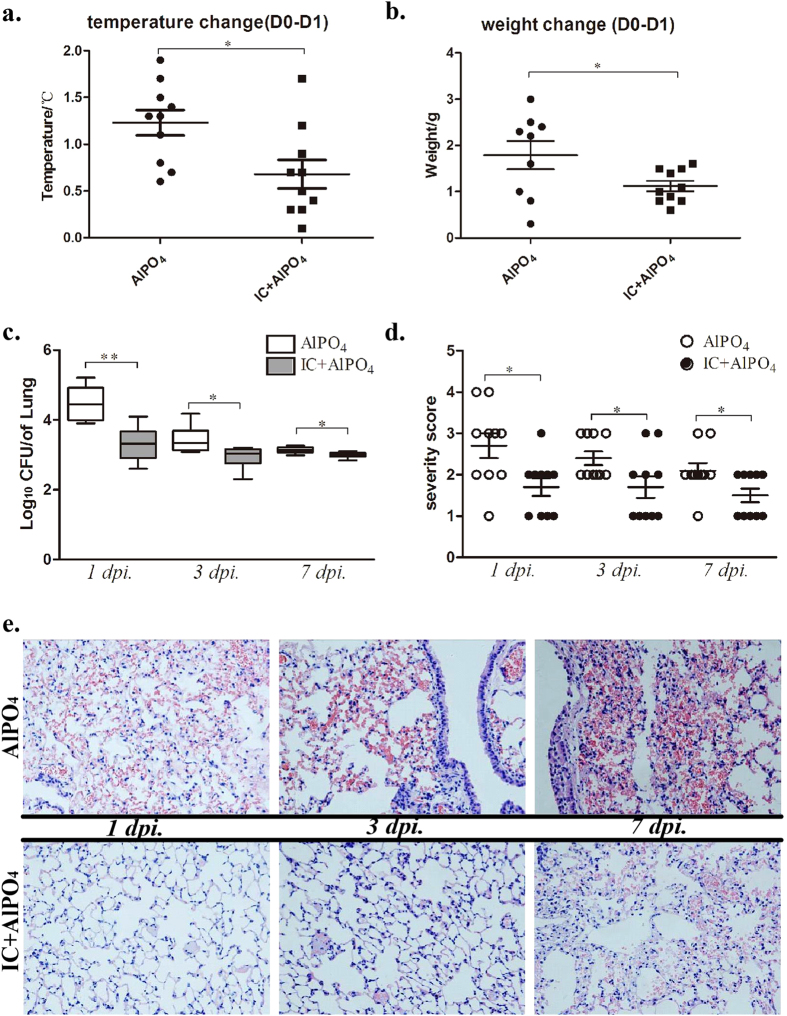
Immunisation with IC can effectively reduce lung damage in an S. aureus pneumonia model.C57 mice (n = 10) were immunised with IC on day 0, 14 and 21, and control group immunised with AlPO4. Mice were inoculated with 4 × 108 CFUs of MRSA252 suspension in the naris on day 28. Temperature and weight changes were measured and shown as temperature(D0-D1) and weight(D0-D1) (a,b). The bacterial burdens (c) were calculated 1, 3 and 7 days post-infection. (d) The histological scores of pneumonia in four groups were monitored and presented as scatter plots. The data was presented as means derived from 3 independent experiments. (e) The representative HE-stained lung tissues (e, magnification = 400×) on 1, 3 and 7 days post-infection were shown.